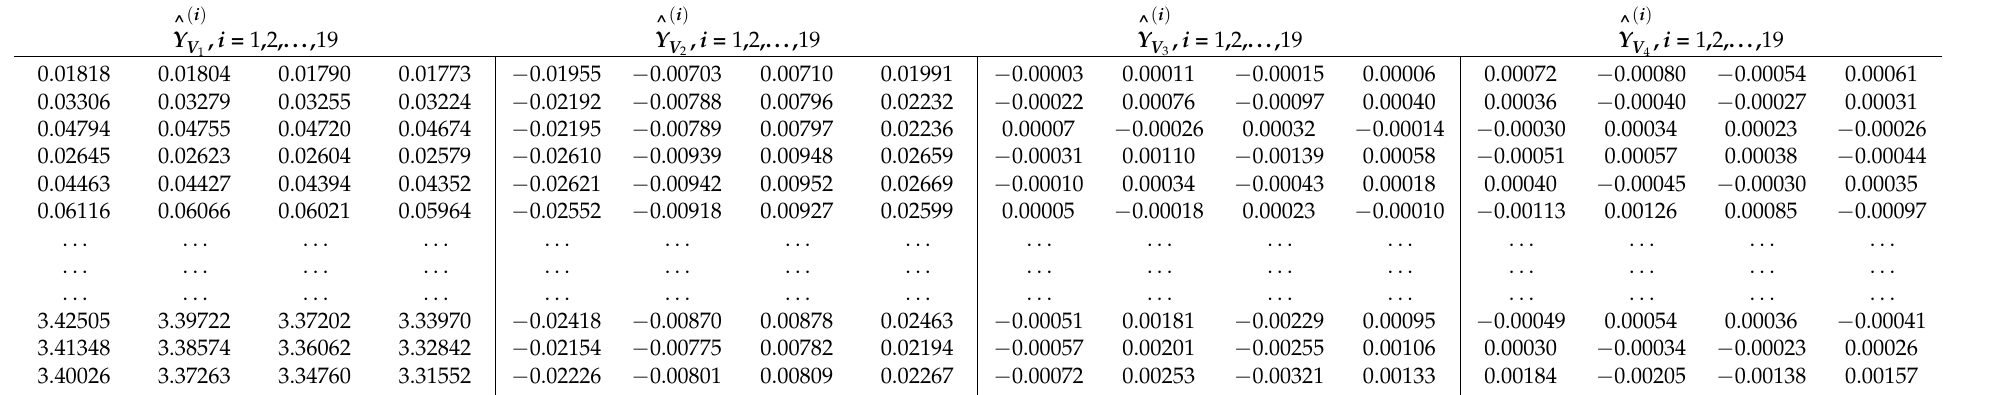
Table 6. Reconstructed trajectory matrix of ˆ Y V .